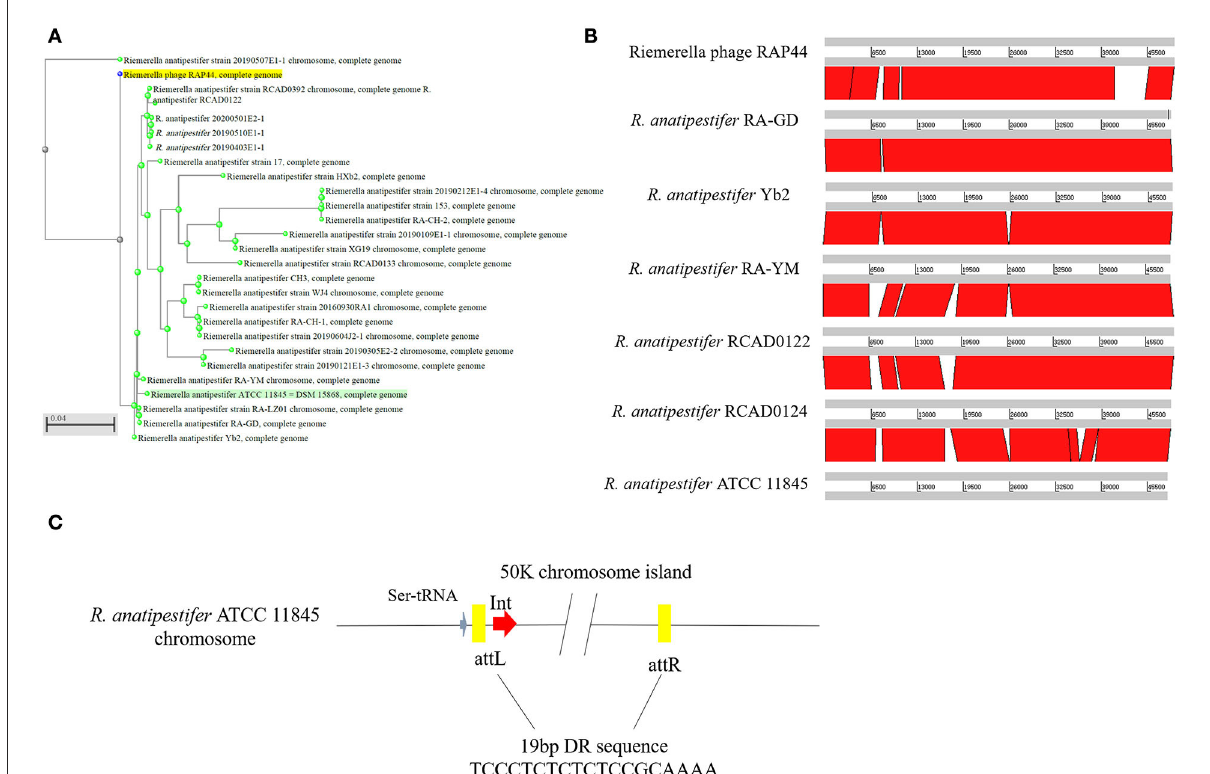
FIGURE3 Evolution and components of 50K genomic island in R. anatipestifer . (A) Comparative genomic analysis of R. anatipestifer genome 50K genomic island and RAP44 genome. The nucleotide sequences alignment was used for the construction of a phylogenetic tree using the neighbor-joining (NJ). (B) The ACT for comparing the difference in 50K genomic islands from six R. anatipestifer strains. (C) The 50K genomic island simulation diagram. 50K genomic island located downstream of tRNA, and 19-bp repeat sequences (TCCCTCTCTCTCCGCAAAA) in the two